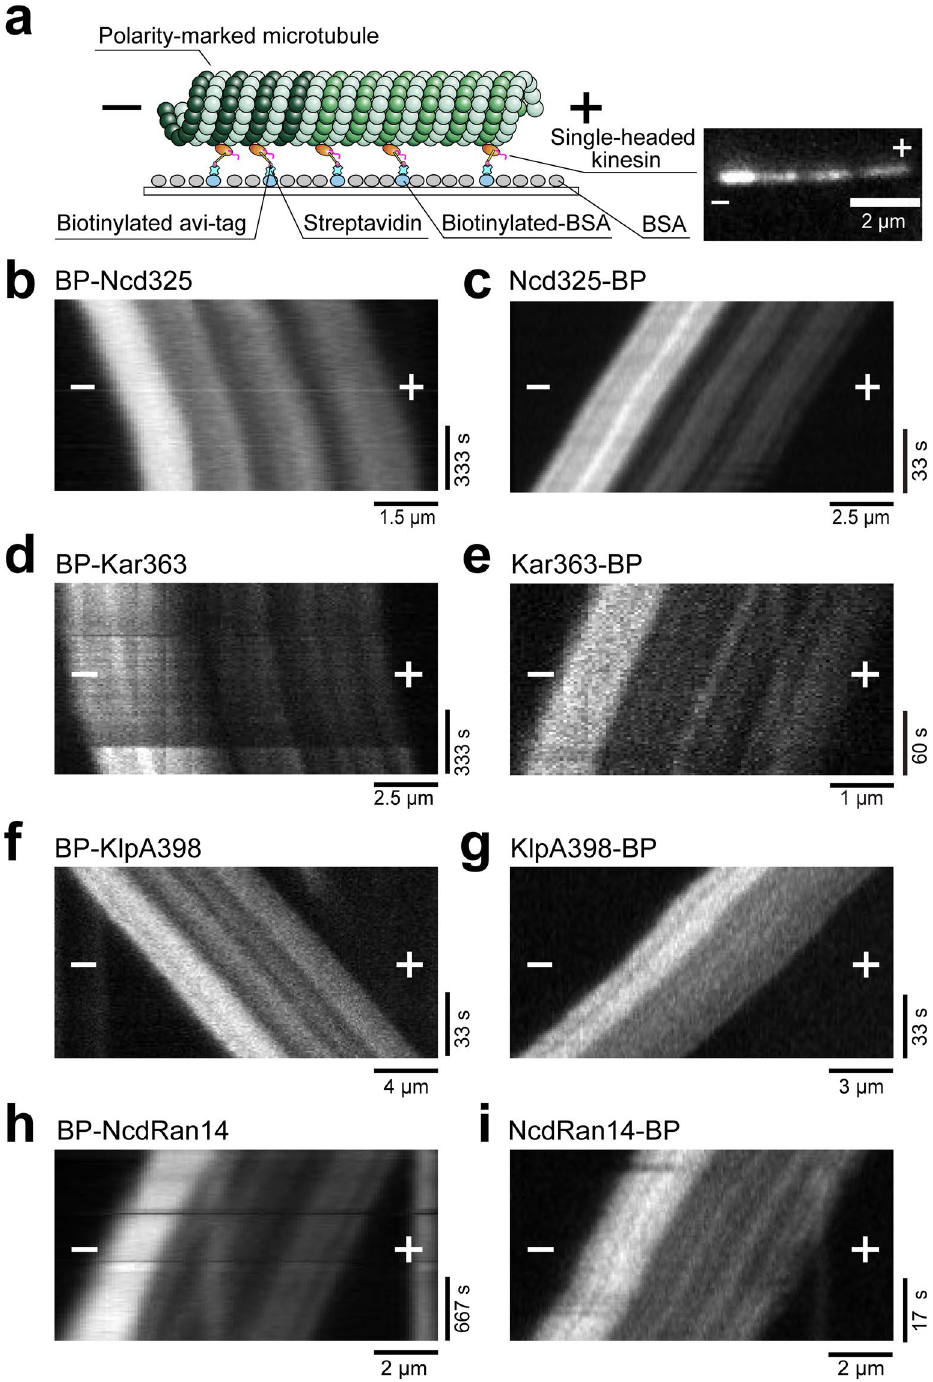
Figure 2. Polarity-marked microtubule gliding assays driven by N- or C-linked monomeric kinesins. ( a ) Scheme of the in vitro polarity-marked microtubule gliding assay. Single-headed kinesins fused to a biotinylated tag (avi-tag) are anchored to biotinylated BSA via biotin-streptavidin linkage. ( b – g ) Typical kymographs of polarity-marked microtubule gliding driven by N-linked monomeric Ncd ( b ), Kar3 ( d ), KlpA ( f ) and C-linked monomeric Ncd ( c ), Kar3 ( e ), KlpA ( g ) are shown. N-linked monomeric kinesin-14s glide microtubules with their dim plus-ends leading, indicating minus-end-directed motor activity, whereas C-linked monomeric kinesin-14s glide with their bright minus-ends leading, indicating plus-end-directed motor activity. ( h , i ) Typical kymographs of polarity-marked microtubule gliding driven by Ncd mutant NcdRan14 are shown. Both N- ( h ) and C- ( i ) linked monomeric kinesins glide microtubules with their bright minus-ends leading, indicating plus-end-directed motor activity. The plus (+) and minus (−) signs refer to the plus-end and minus-end of the microtubules,